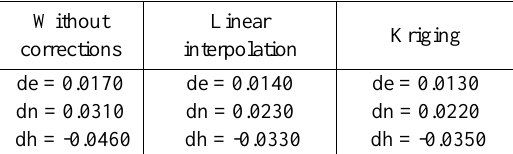
Table 3. Master-Rover baseline processing accuracy